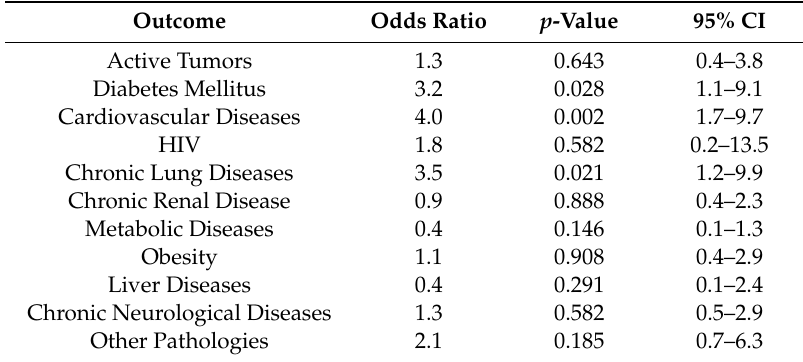
Table 2. Conditional regression analysis for the association between case status (patients deceased with SASRS-Cov-2 and paired control patients) and underlying health